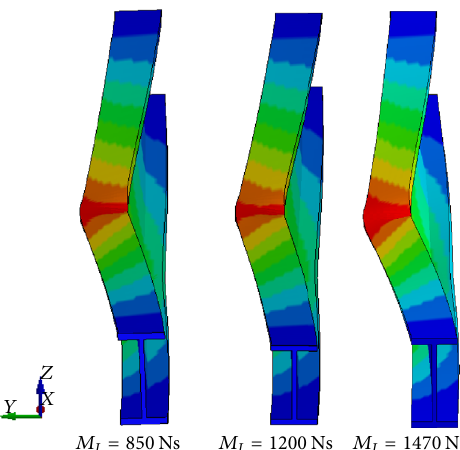
Figure 30: Plastic deformation of beam under different impact momentums.